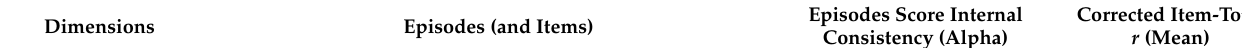
Table 2. Lab-TAB Behavioral Inhibition composite scores: structure, internal consistency, and discrimination.